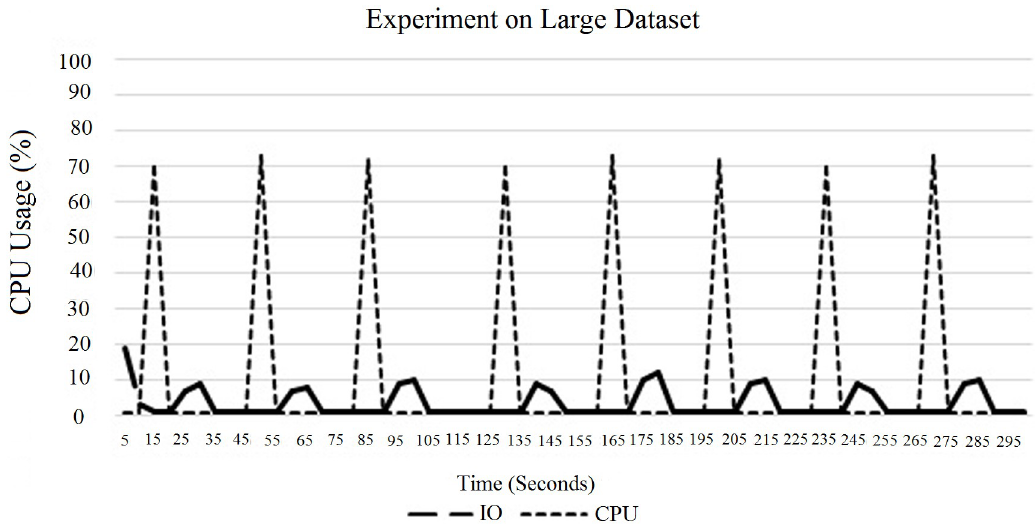
Fig 23. CPU and IO usage on a large data-set for a single DataNode.